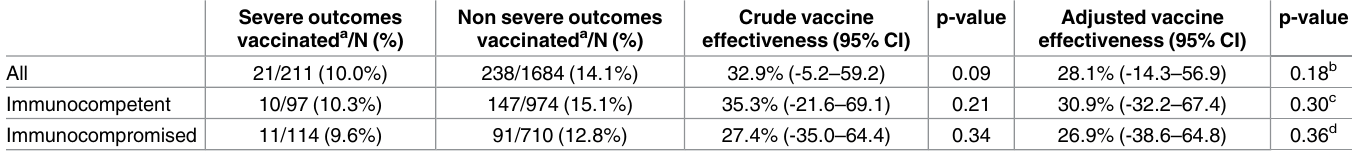
Table 4. Effectiveness of the PPSV23 in avoiding intensive care unit admission or death in hospitalized patients with community-acquired pneumonia. Severe outcomes vaccinated a /N